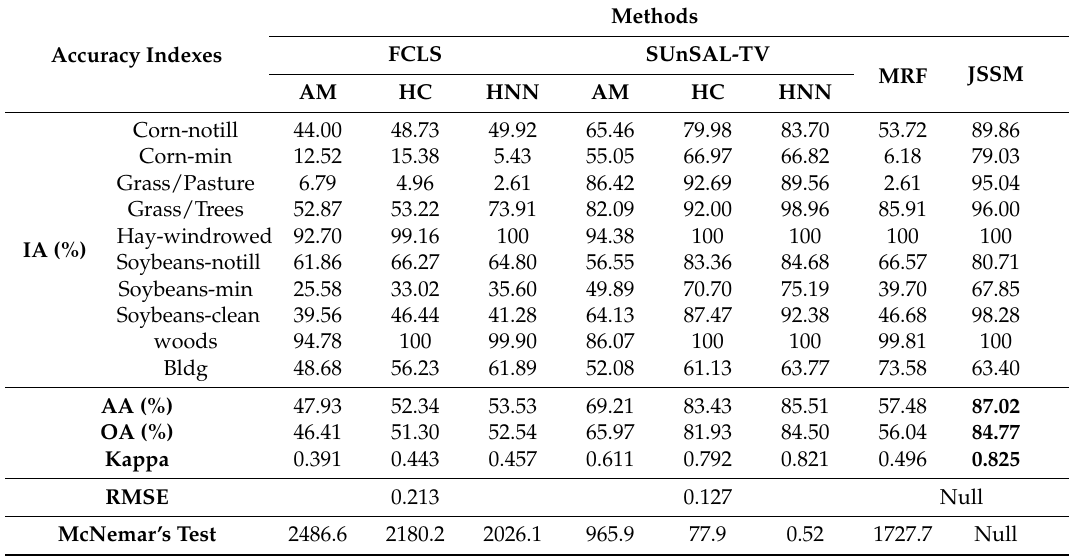
Table 3. Sub-pixel mapping results for the Indian Pines